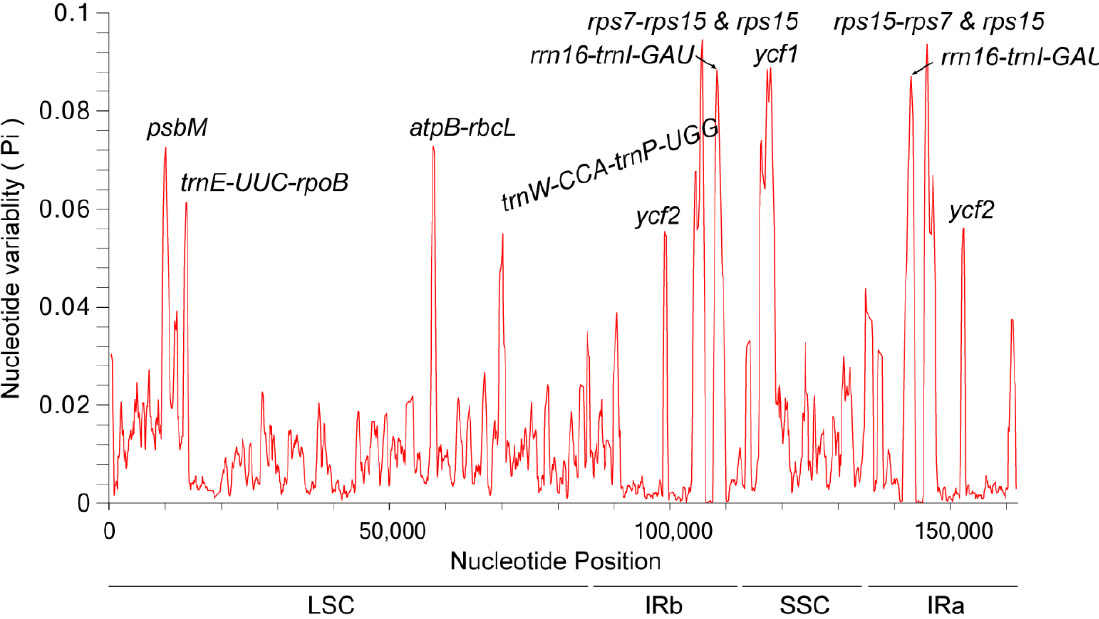
Figure 8. Sliding window analysis for the nucleotide diversity ( π ) of the whole chloroplast genomes for Eupatorieae species. X -axis: position of the midpoint of a window, Y -axis: nucleotide diversity (pi) of each window.